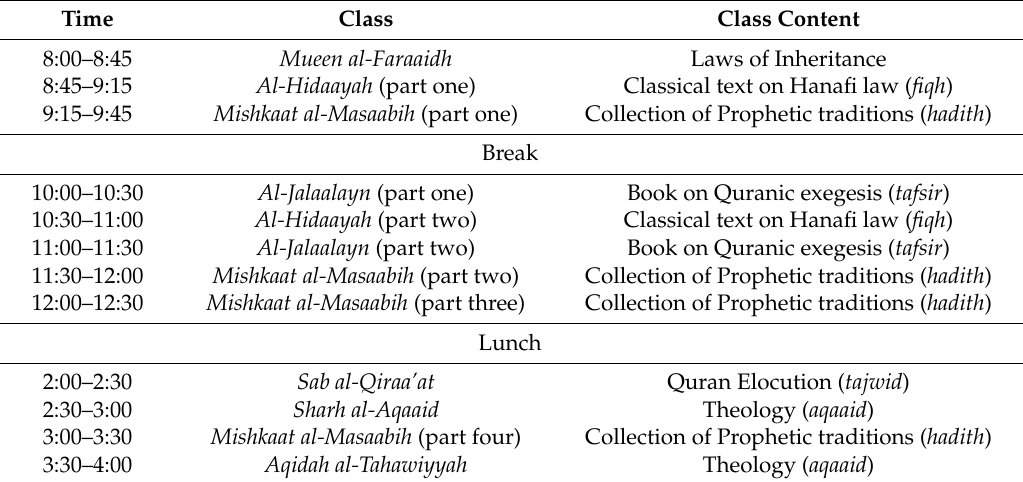
Table 1. A typical timetable for a fifth-year dars-i nizami